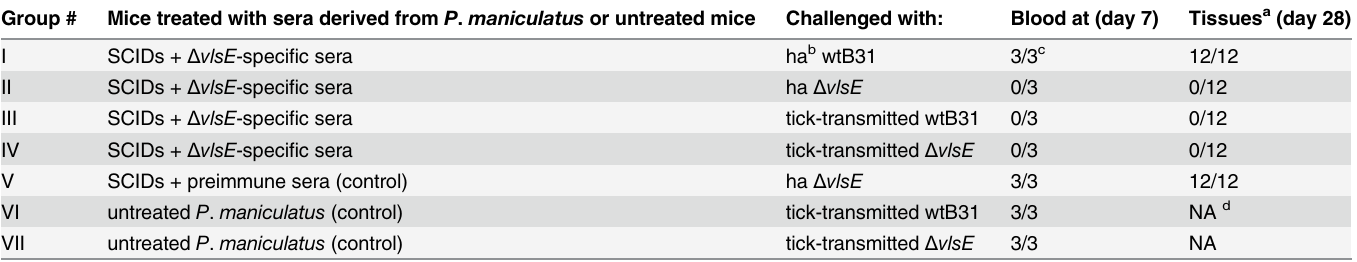
a Tissues harvested and cultured from each mouse include ear, heart, bladder and tibiotarsal joint. b ha denotes host-adapted clone. c Values listed correspond to numbers of cultures positive/numbers tested. d NA denotes not